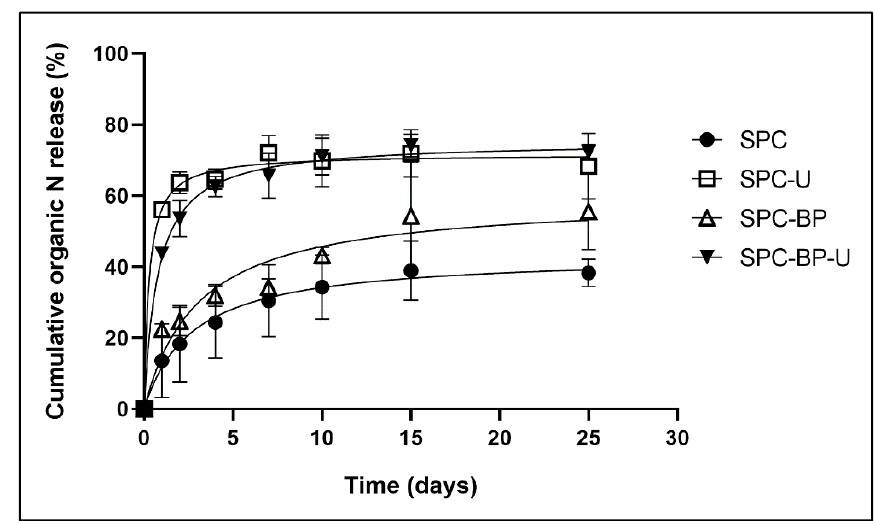
Figure 11. Percentage of initial N released in solution as total organic N.